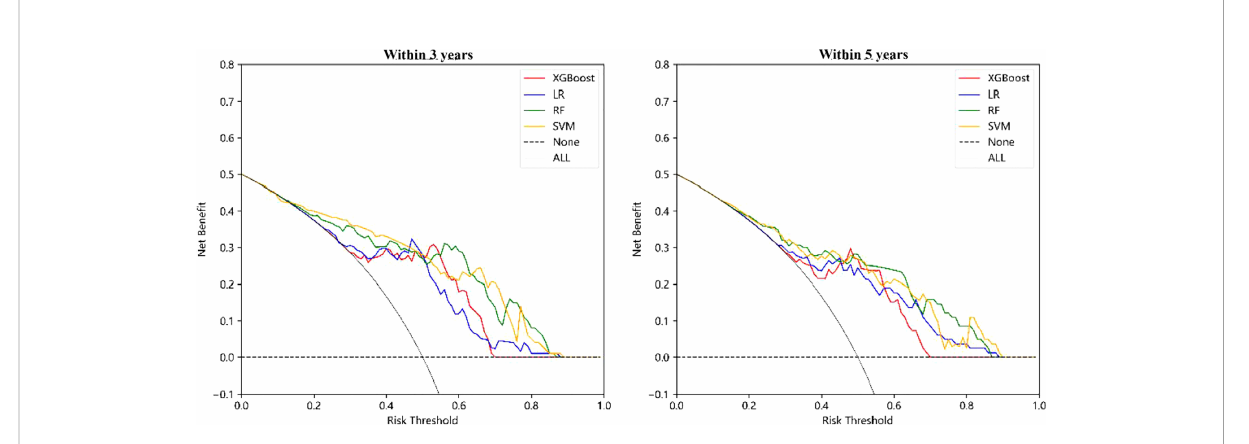
FIGURE 3 DCA curve of “ Chinese medicine intervention prognostic model ” .